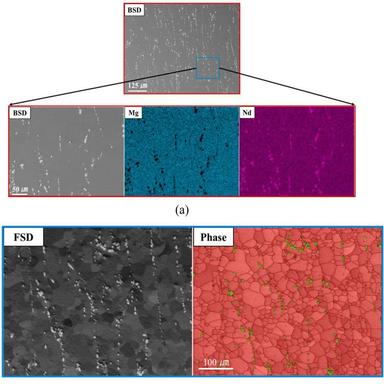
(a) SEM-BSD image and corresponding EDS elemental distribution maps of ZM6 alloy prior to the oxidation testing; (b) FSD image and phase map (α-Mg in red and Mg12Nd in green).